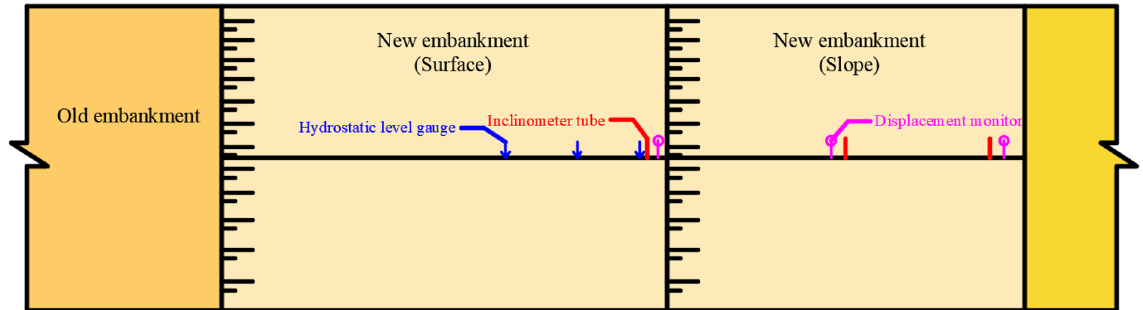
Figure 8. Schematic replacement of the new embankment monitoring instrument arrangement.